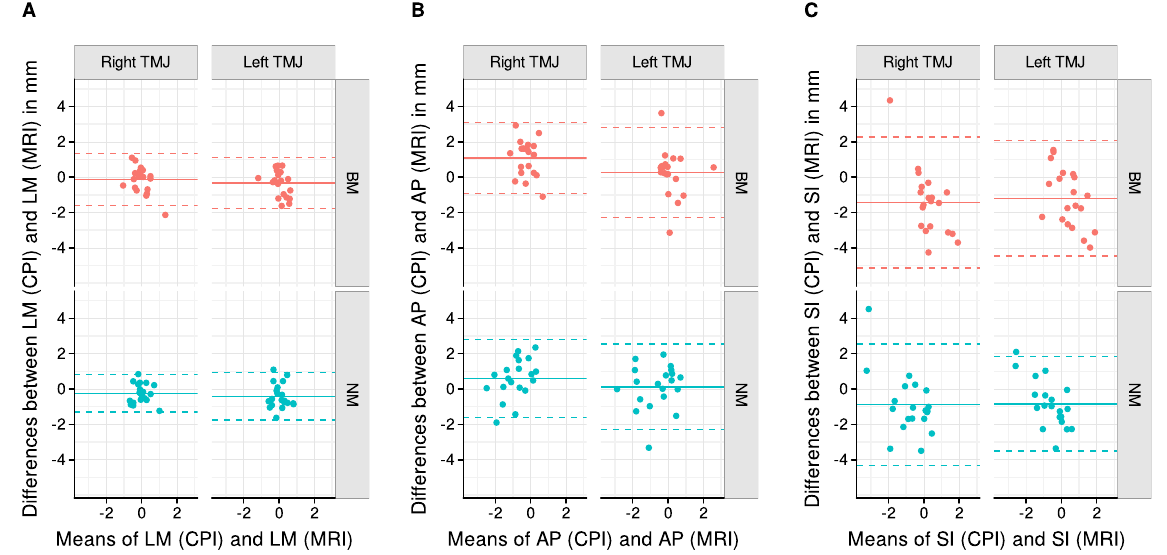
Figure 3. Bland–Altman plots. Illustrations display differences between CPI and MRI condyle position data in millimeters (mm) for lateral–medial (LM), anterior–posterior (AP), and superior–inferior (SI) directions, separately for left and right temporomandibular joints (TMJ) as well as BM and NM positions.